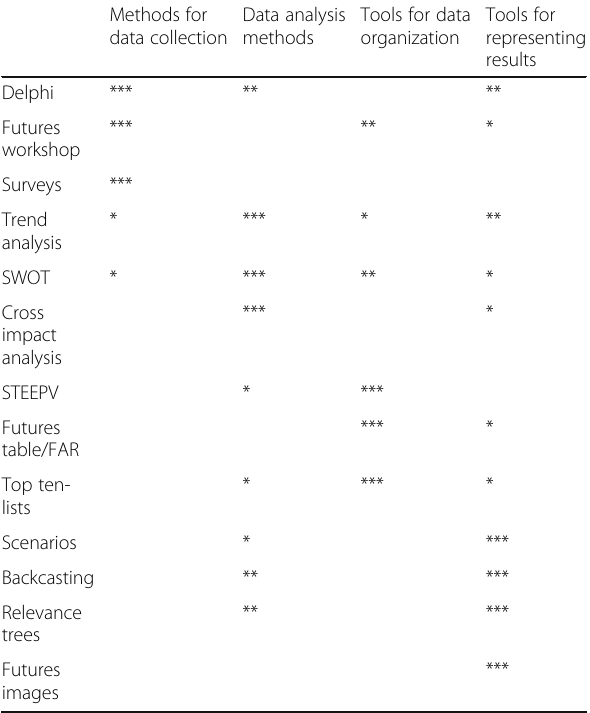
Table 5 Vinnari and Tapio ’ s classification Methods for Data analysis data collection